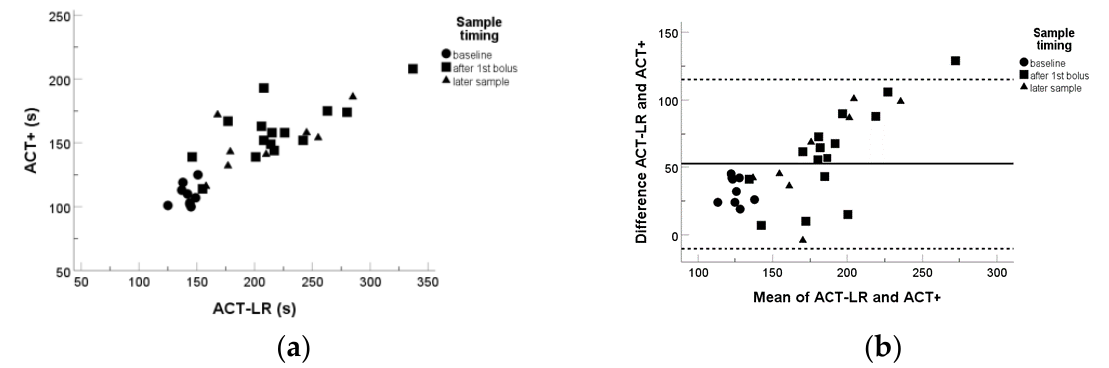
Figure 2. ACT-LR and ACT+ (Hemochron ® ) correlated with one another fairly well R 2 = 0.70 ( a ). ACT-LR was consistently more prolonged than ACT+ when measured in parallel. Differences increased after heparin bolus, Bland–Altmann plot with mean for difference (solid line) and ± 1,96 SD (dashed lines) are shown ( b ).